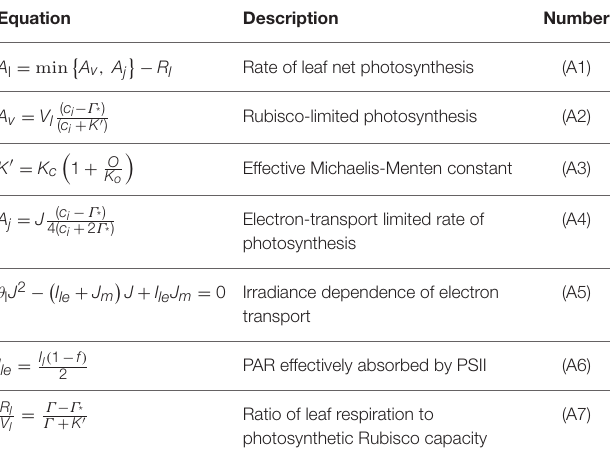
TABLE 2 | Equations of the FvCB model.